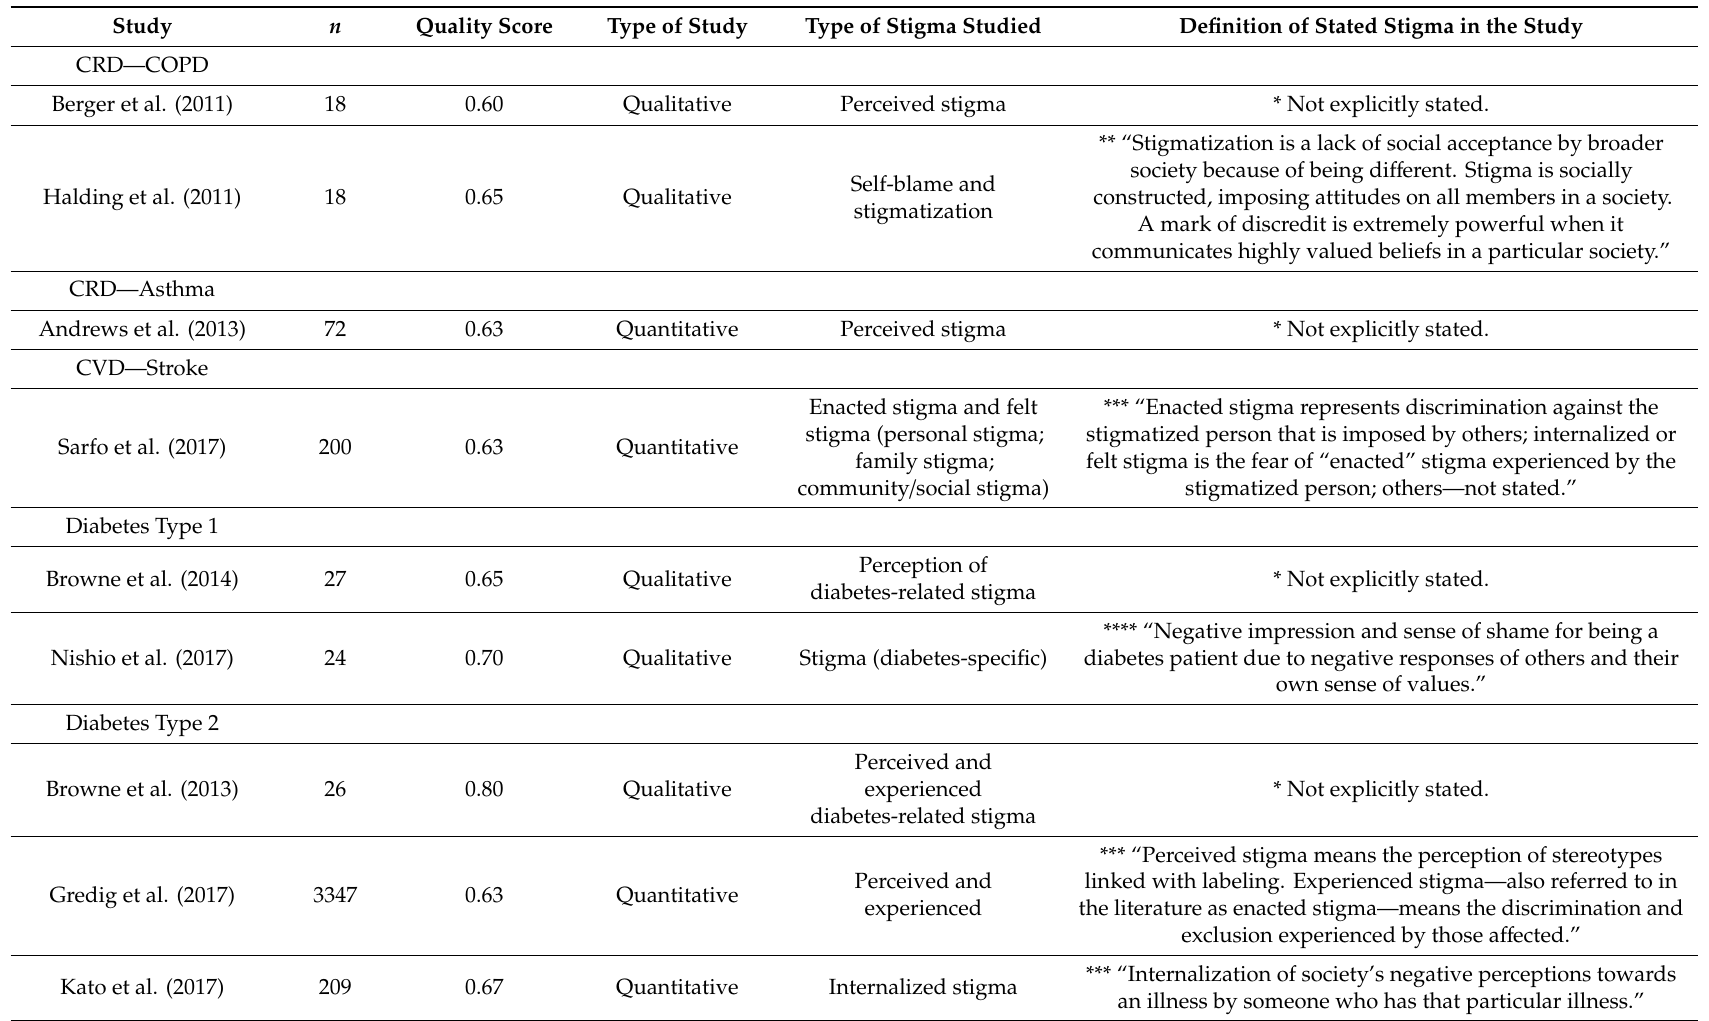
Table 2. Definitions of stigma used in the